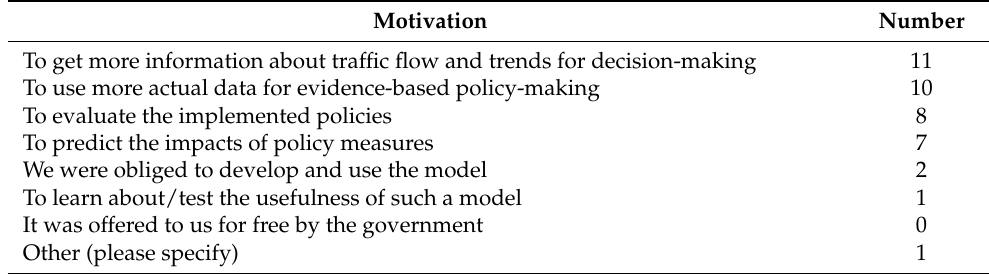
Table 2. Reasons to start using GIS models (more than one answer possible, N = 16